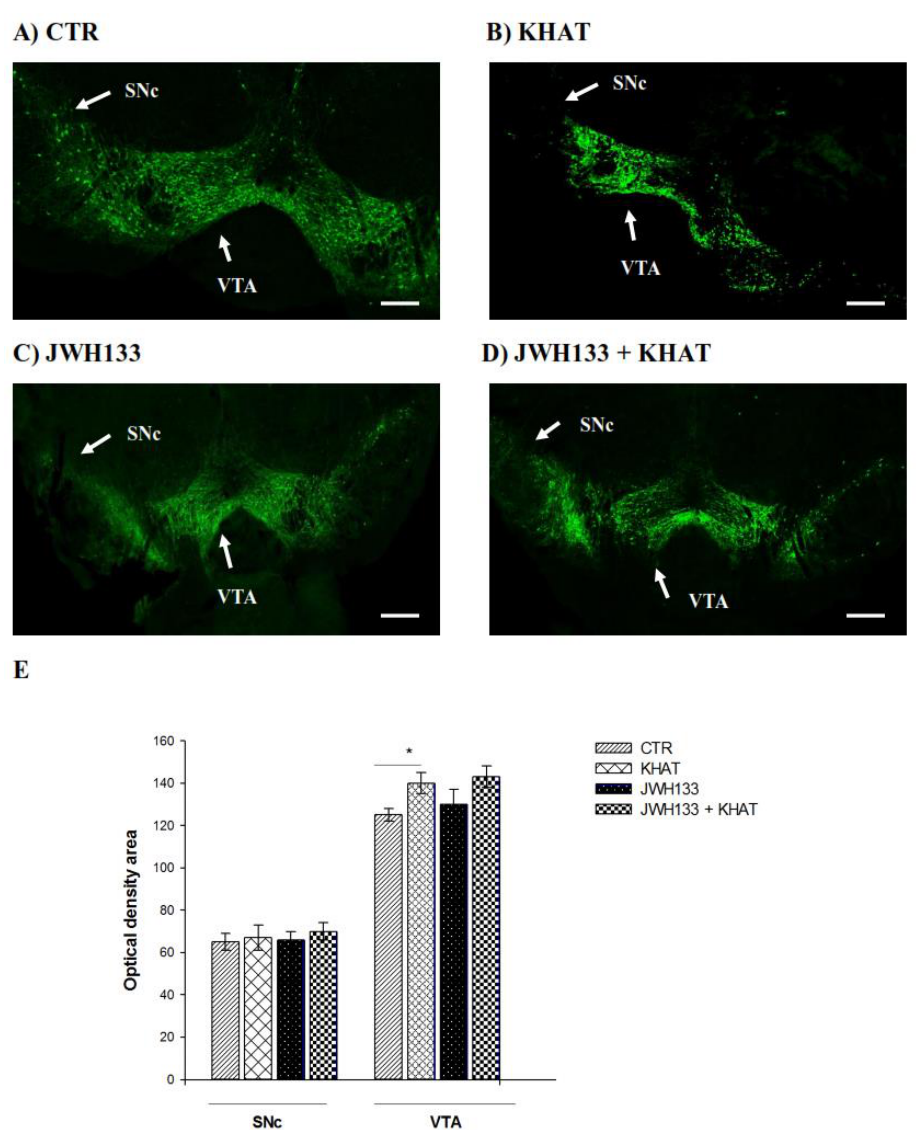
Figure 5. Effect of sub-acute administration of khat extract alone and in combination with JWH133 on immunohistochemical staining for TH-positive cells in WT mice. ( A – D ) Representative photomicrographs of TH immunoreactive neurons in the substantia nigra pars compacta (SNc) and ventral tegmental area (VTA) region. Scale bar, 100 μm. ( E ) The number TH positive cells (optical density area), and the data were expressed as mean ± SEM (n = 6 in each group). Statistical analysis was done using one-way ANOVA followed by Tukey ′ s multiple comparison test. * p < 0.05. CTR (control group received the vehicle); KHAT (treatment group received khat extract 300 mg/kg); JWH133 (treatment group received JWH133 5 mg/kg); JWH133 + KHAT (treatment group received a combination of JWH133 5 mg/kg with khat extract 300 mg/kg). The vehicle, JWH133, and khat extract were administered to mice once daily for seven consecutive days.